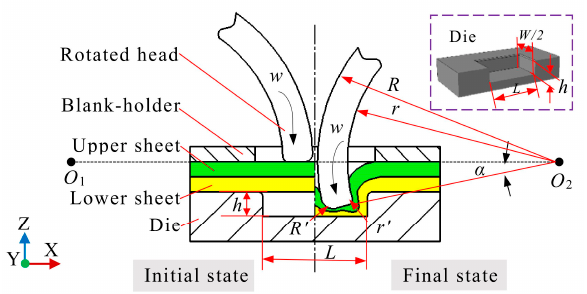
Figure 1. Rotated clinching process (X: longitudinal direction, Y: transverse direction and Z: thick- ness direction).